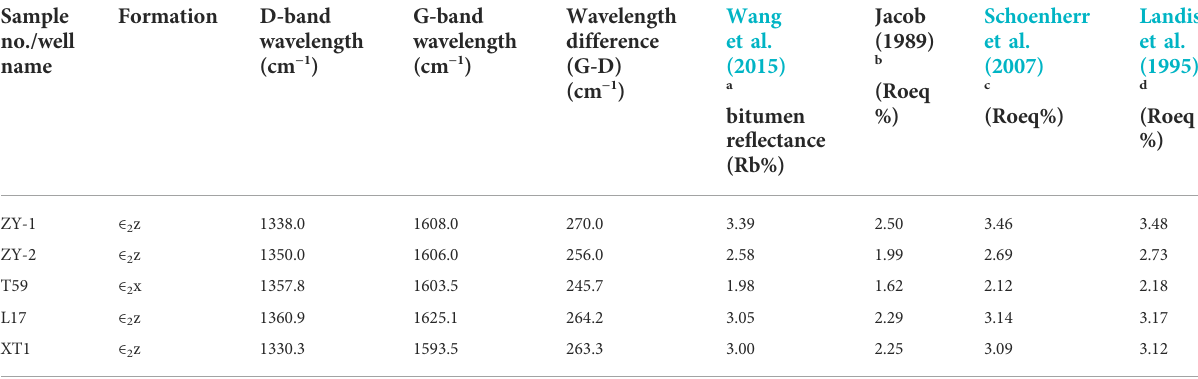
TABLE 1 Cambrian bitumen re fl ectance (Rb) data in the reservoirs of the Ordos Basin and their conversion into vitrinite equivalent re fl ectance (Roeq) values according to different authors. Sample no./well